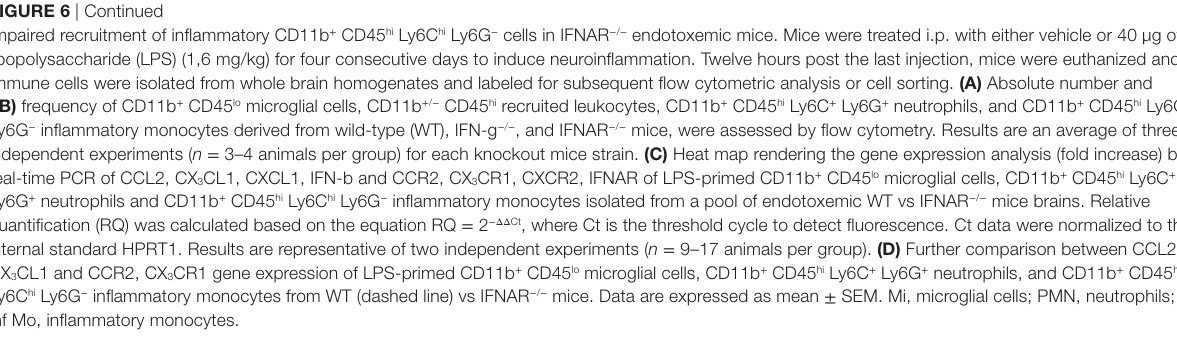
FigUre s1 | Gating strategy sequence applied for the flow cytometric analysis and cell sorting. Mice were treated i.p. with 40 µg of lipopolysaccharide (LPS) (1,6 mg/kg) for four consecutive days to induce neuroinflammation. Twelve hours post the last injection, mice were euthanized and immune cells were isolated from whole brain homogenates and labeled for subsequent flow cytometric analysis or cell sorting. (a) FSC vs SSC, FSC-W vs FSC-H, and SSC-W vs SSC-H flow cytometry density-plots illustrating the gating analysis strategy employed to exclude cell doublets. (B) Hierarchical gate view depicting the strategy sequence adopted to assess the phenotypic features of immune cells. Representative rectangle gates were used in all cases for statistical purpose rather than for selection of a cell